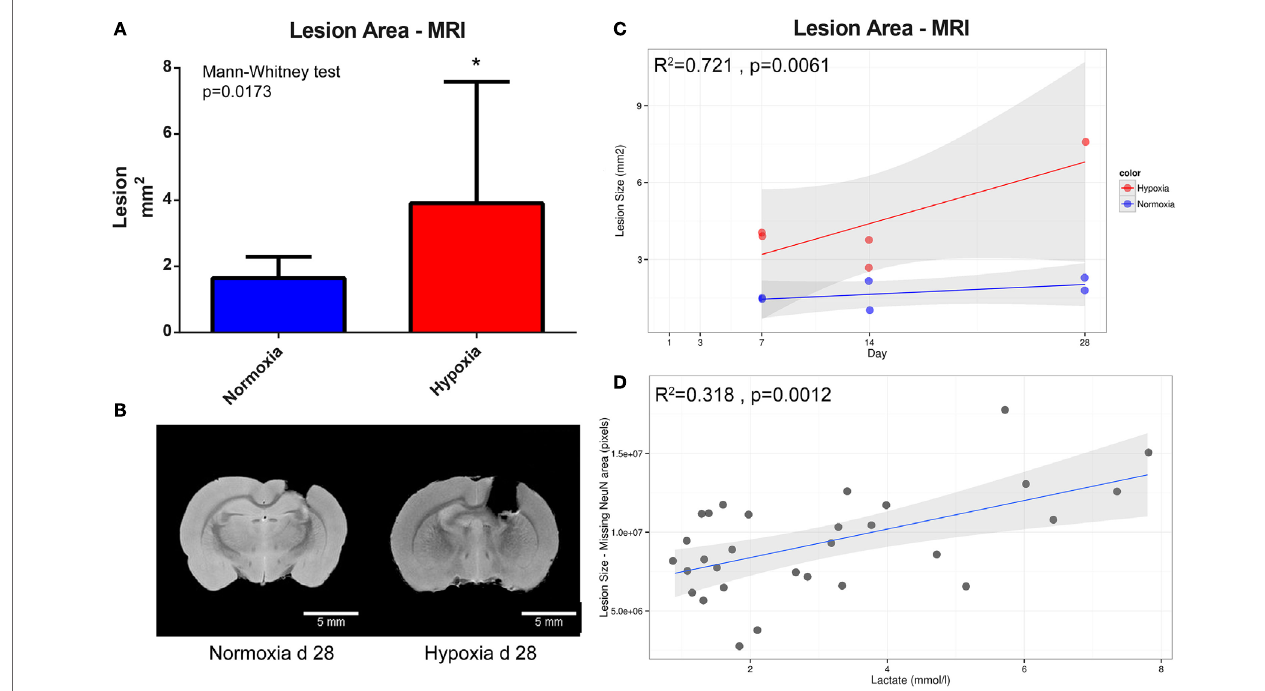
FigUre 5 | lesion size quantification . (a) illustrates the difference in lesion size between the normoxic ( n = 6) and hypoxic group ( n = 5) at day 7, 14, and 28 post-CCI presented as mean and SD. In (B) , the lesion size on two representative animals is presented at day 28 following TBI; normoxia (left) and hypoxia (right). Scale bar = 5 mm. (c) illustrates changes in lesion size on MRI ( y -axis, mm 2 ) over time ( x -axis, survival time in days) in hypoxic (red) and normoxic (blue) rats ( R 2 = 0.721). The gray area represents 95% confidence interval while the line is a regression line. (D) Correlations between the neuronal death using tissue area devoid of NeuN staining ( y -axis, pixels) and all available lactate levels ( x -axis, mmol/l) acquired from blood gas post surgery; as lactate increases, so does the lesion size ( R 2 = 0.318).